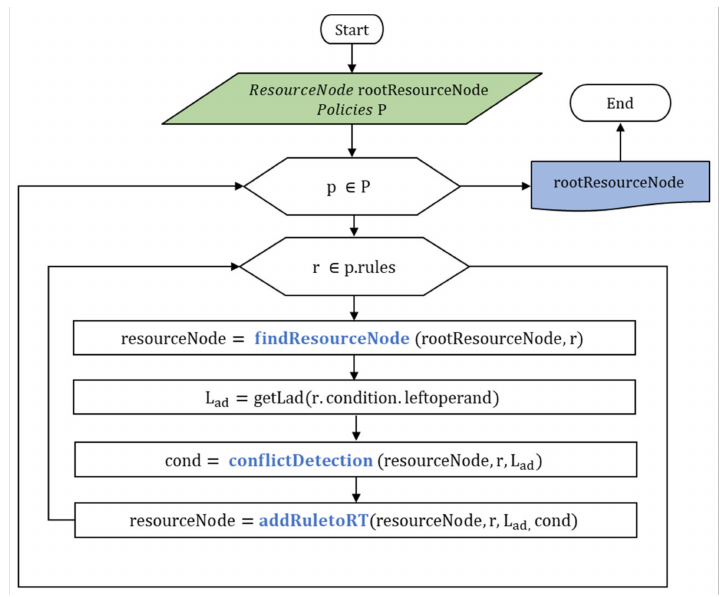
Figure 10. Common Resource Conflict Detection Algorithm Flow Diagram.